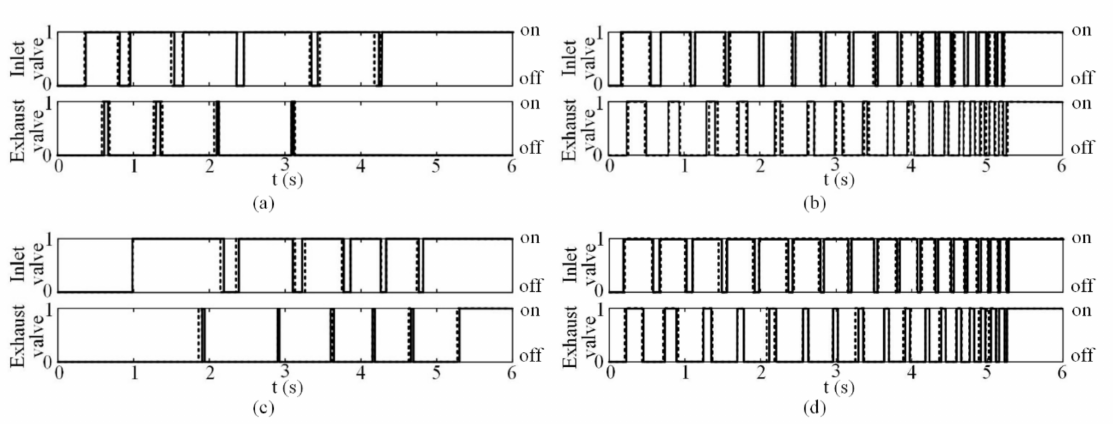
Figure 11. Results of ABS valve operation logic test on bisectional road: ( a ) first axle left wheel; ( b ) first axle right wheel; ( c ) second axle left wheel; ( d ) second axle right